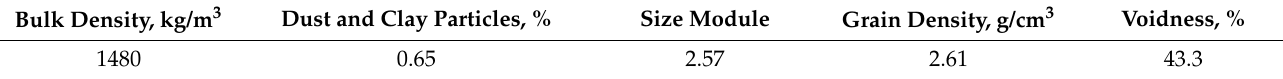
Table 4. Physical and mechanical characteristics of fine aggregate.